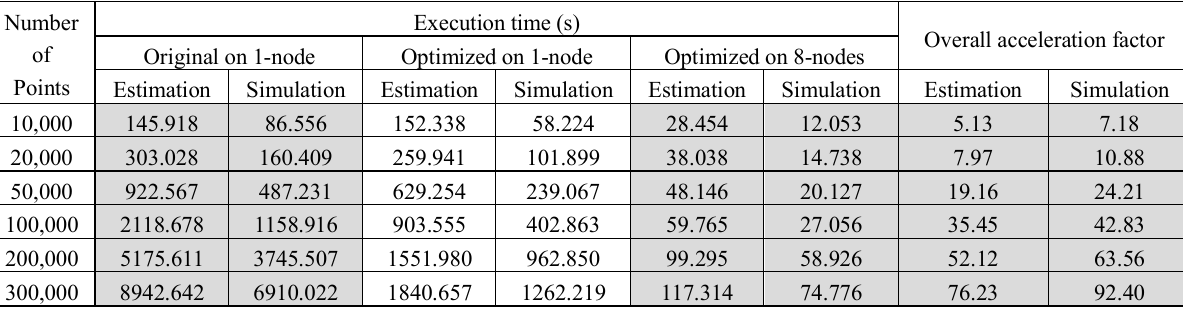
Table 1. Overall speedup of space K function by adopting optimization strategies and clustering